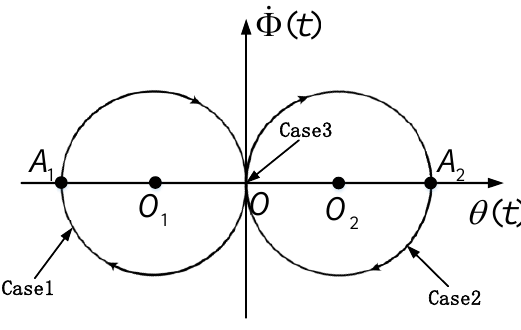
Figure 3. Phase plane of the payload.